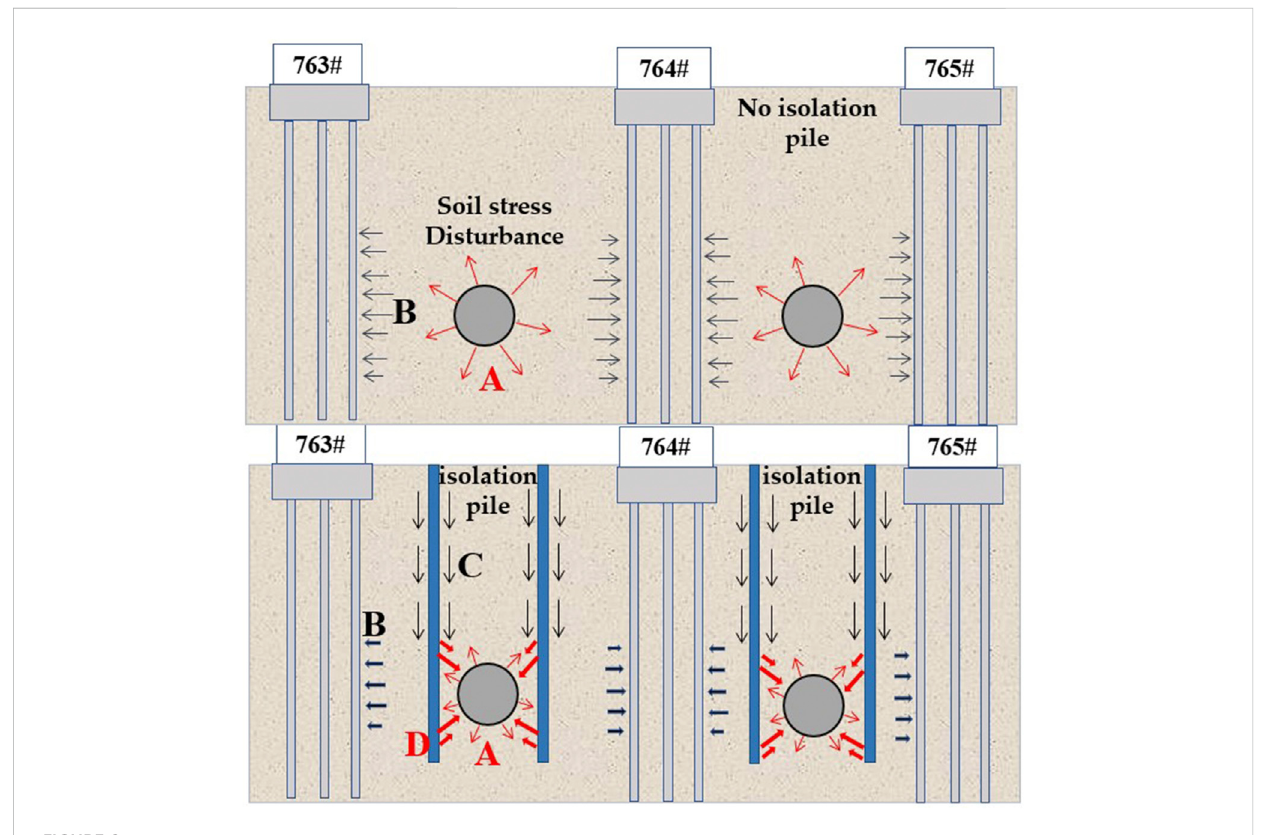
FIGURE 2 Mechanism of isolation pile